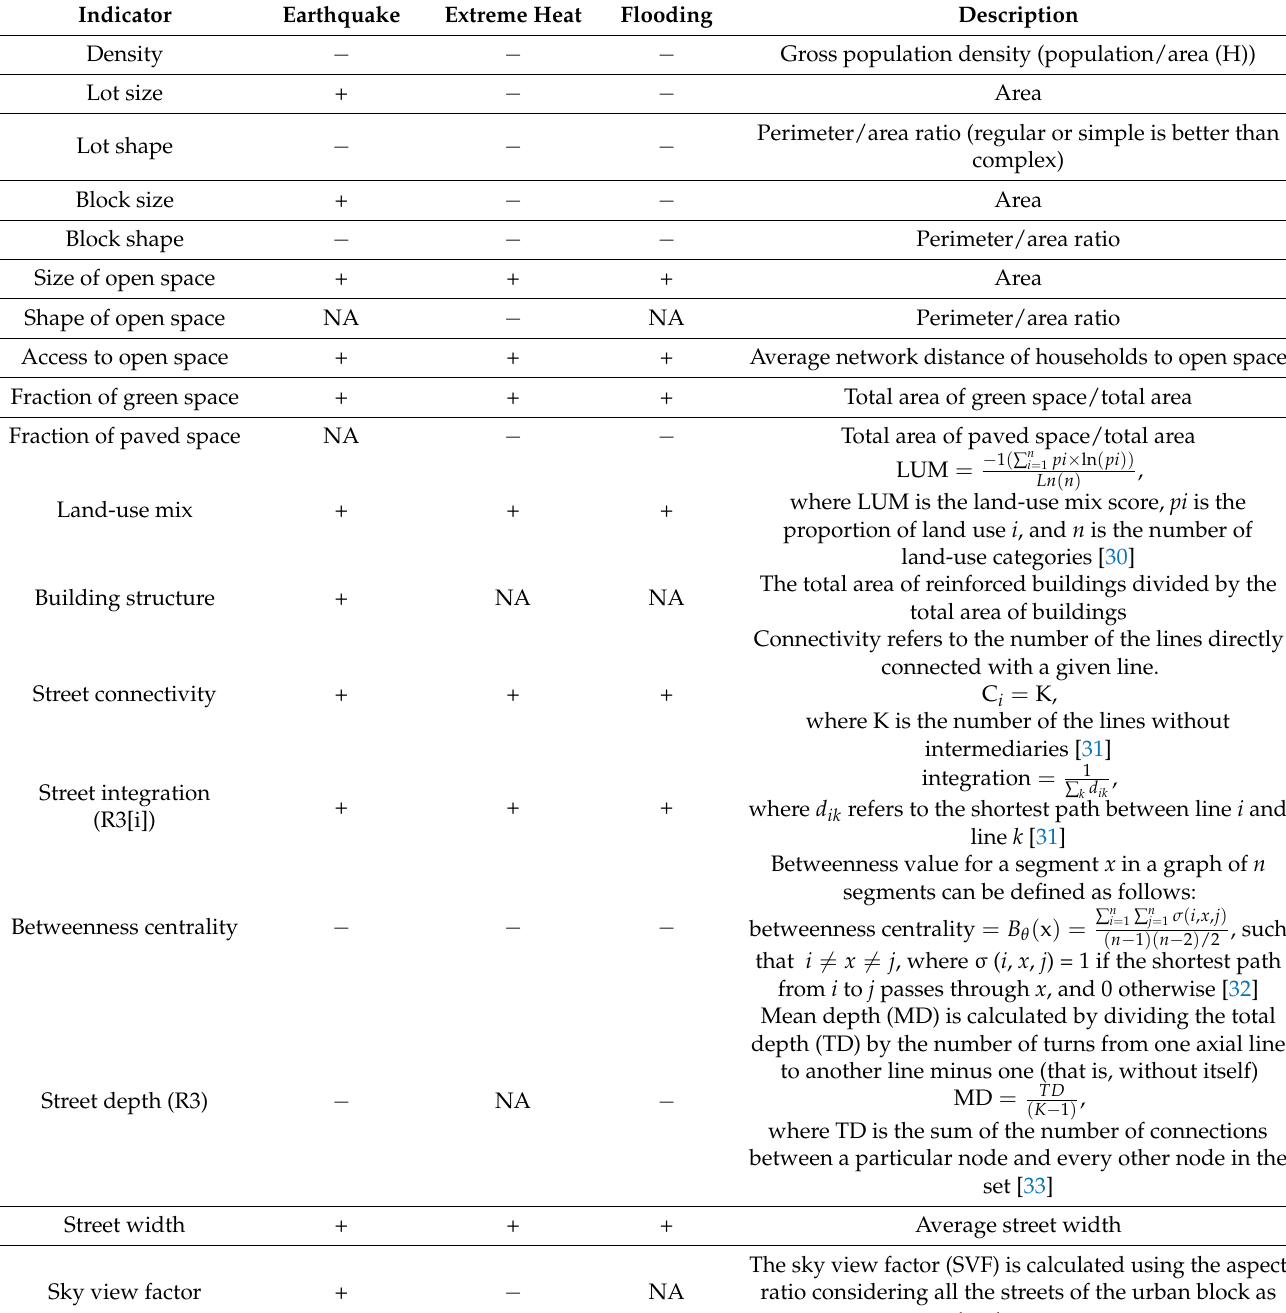
Table 2. Some descriptive statistics related to the selected neighborhoods (source: master plan of Shiraz). NA, not applicable. Indicator Earthquake